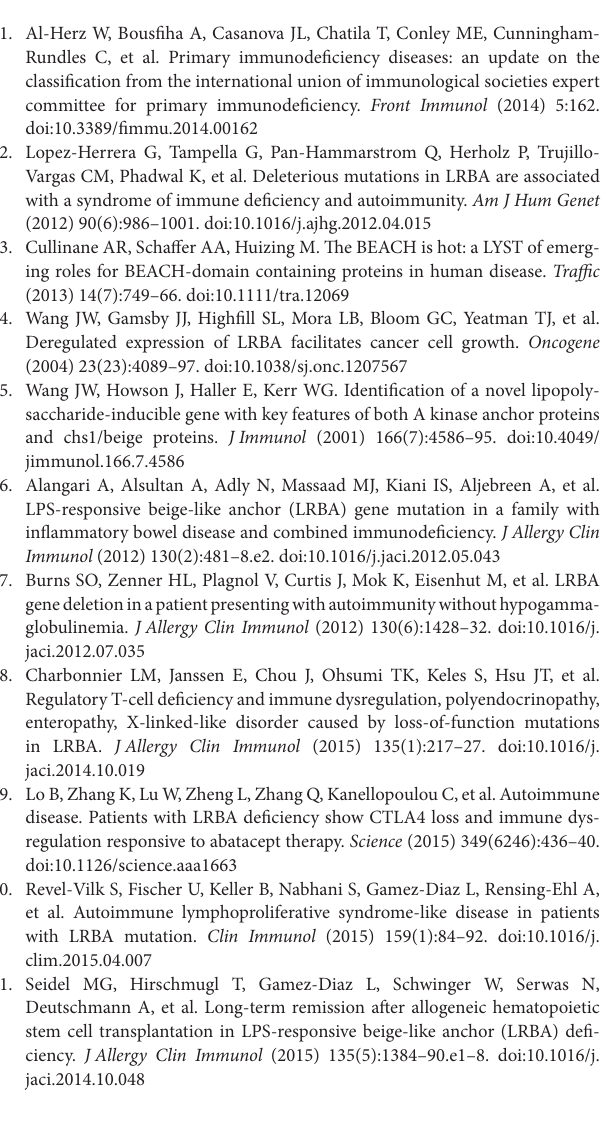
3 days (black squares) (A) , or by western blotting in fresh PBMCs from three healthy donors before and after stimulation with PHA (B) . FIGURe s4 | LRBA expression is not affected by (A) the type of anticoagulant use for blood withdrawal, by the time of withdrawal, or (B) by frozen storage. FIGURe s5 | Scatter plots representing the LRBA-MFI ratio distribution of the different 16 definitive LRBA patients (red dots), and 41 non-LRBA patients (green dots) according to their respective healthy donors (blue dots). tABLe s1 | Classification of patients with a suspicion of LRBA deficiency. tABLe s2 | LRBA mutations identified in our patient’s